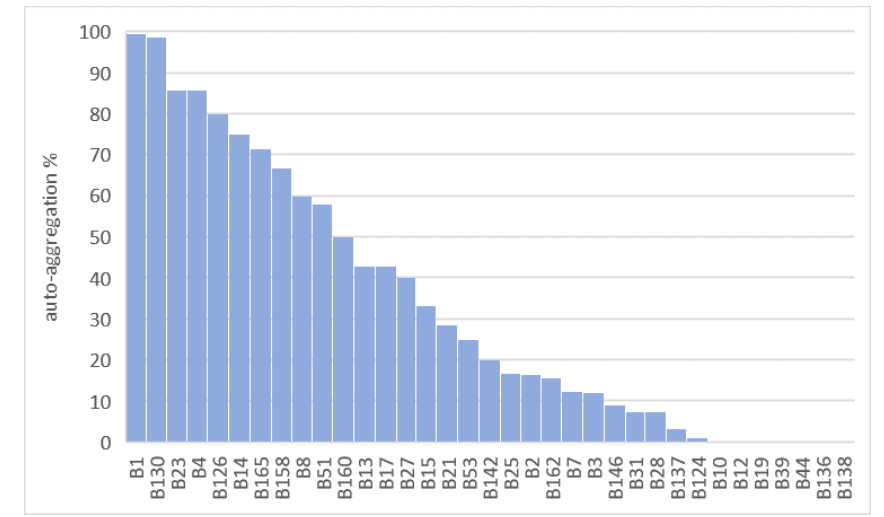
Figure 2. Distribution of the auto-aggregation assay.